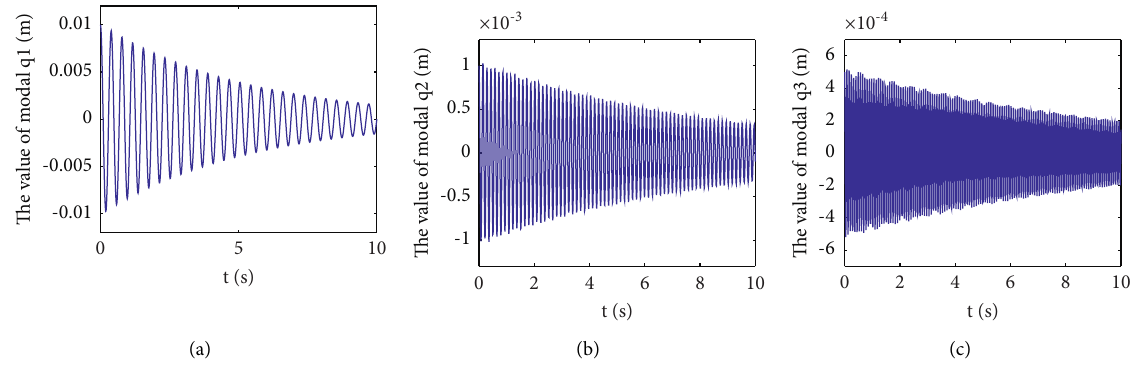
Figure 4: Generalized coordinate curve of flexible deformation: (a) q 1; (b) q 2; (c) q 3.